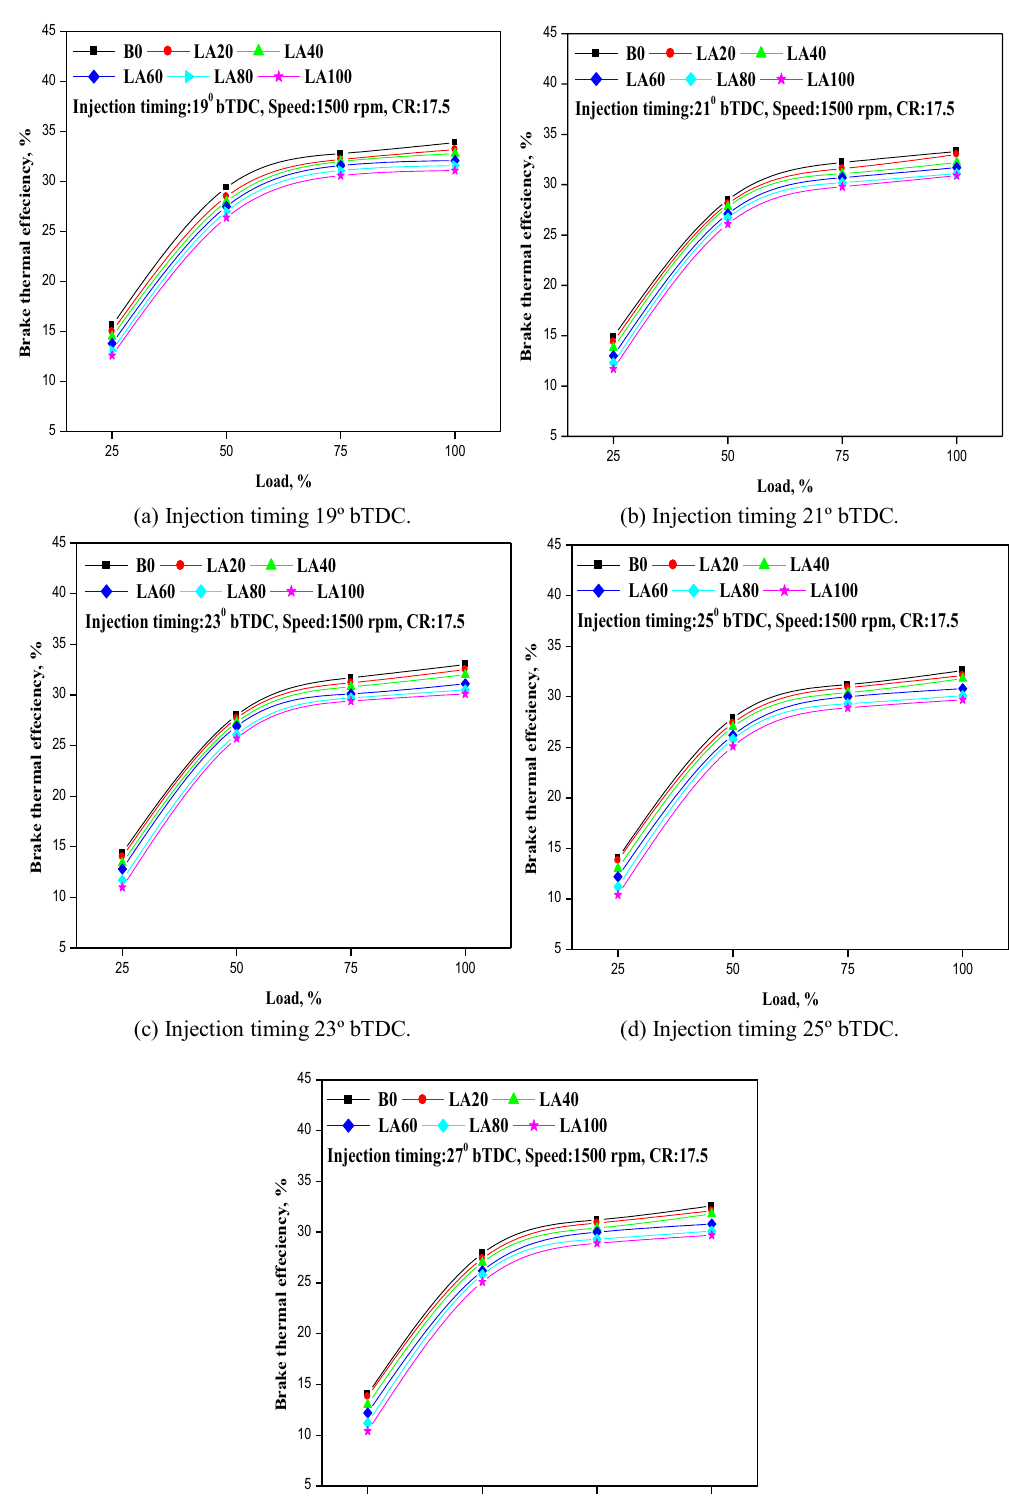
Figure 4. ( a–e ) The variation in BTE with different injection timing and engine load for test fuel